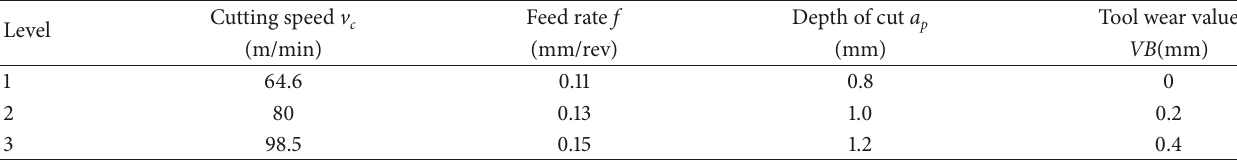
Table 2: Experimental parameters and levels.